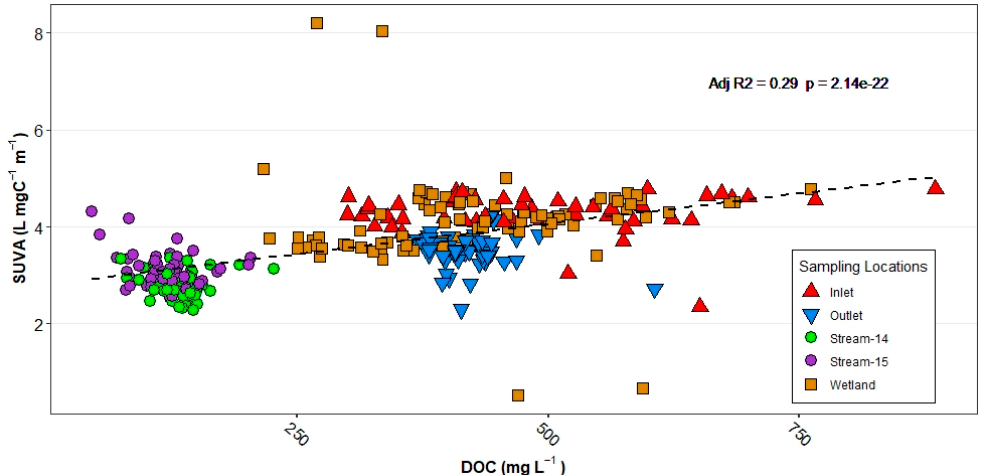
Figure 3. Relationship between specific ultraviolet absorbance (SUVA) and dissolved organic carbon (DOC) at the Arbutus Lake watershed. Three SUVA values > 20 L · mg C − 1 m − 1 from Summer 2017 are (DOC) at the Arbutus Lake watershed. Three SUVA values > 20 L·mg C − 1 m − 1 from Summer 2017 are not included in this not included in this plot.